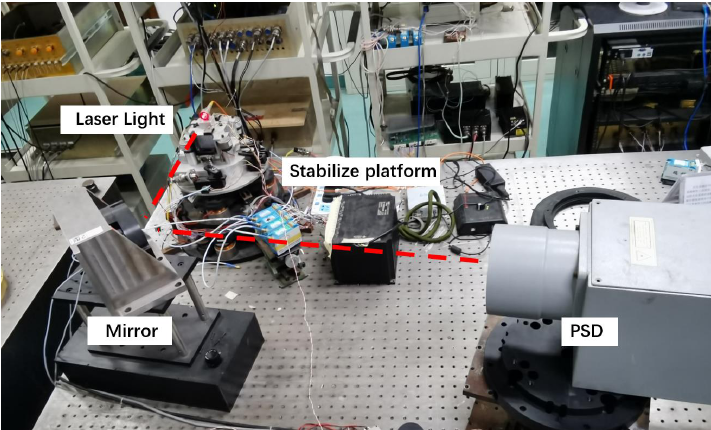
Figure 3. Experimental apparatus. The light travels along the red dotted line path in the figure and is reflected by the mirror before being collected by the